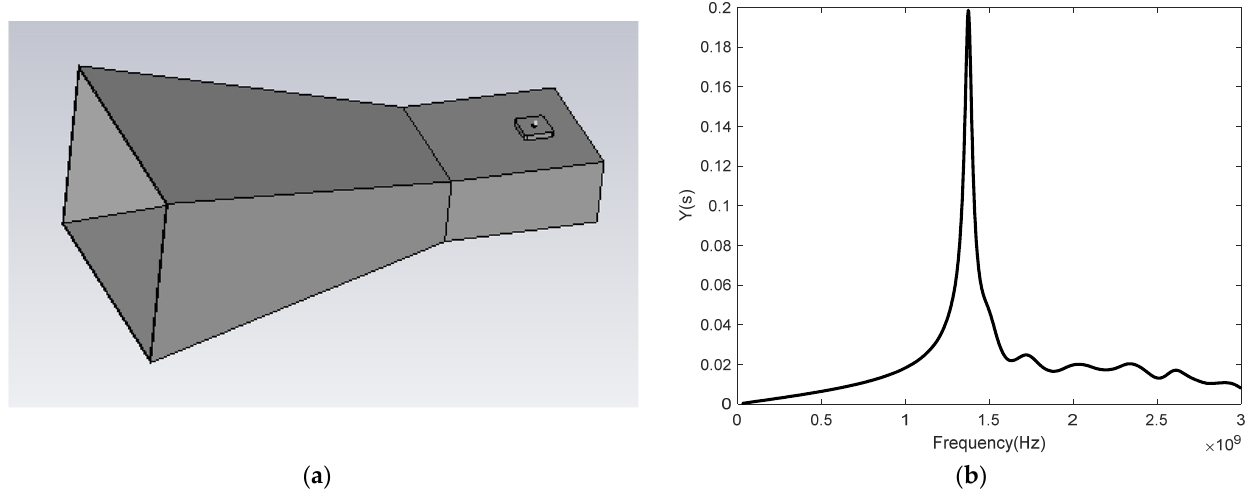
Figure 7. EM models of pyramid horn antenna: ( a ) EM model; ( b ) Admittance.